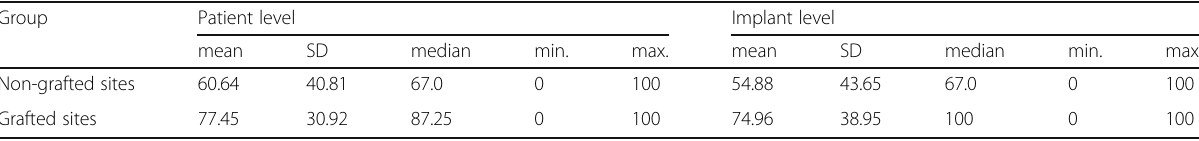
Table 3 Reduction of mean BOP (%) Group Patient level Implant level mean SD median Non-grafted sites Grafted